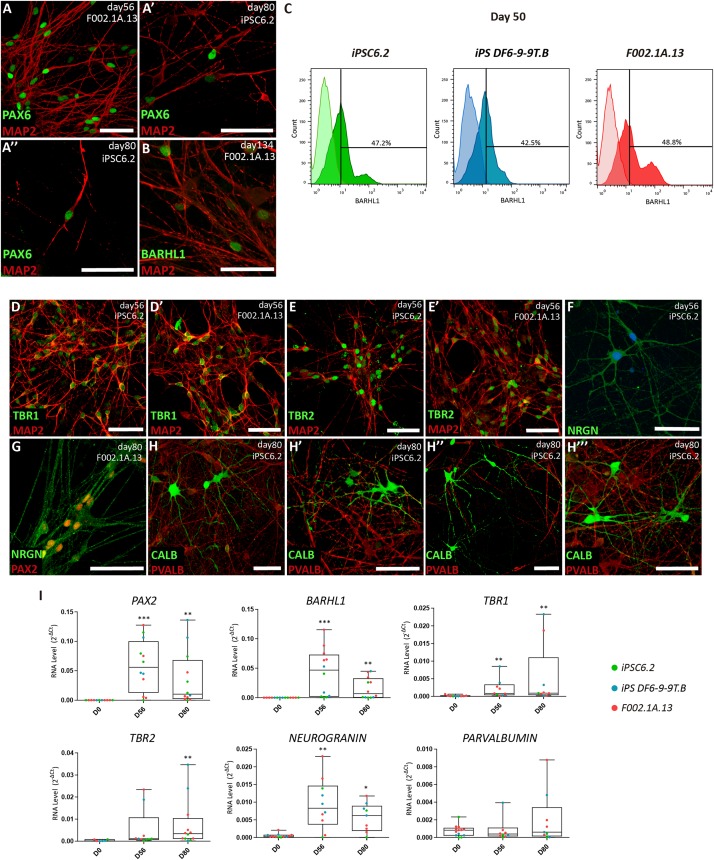
Maturation of distinct types of cerebellar neurons in 2D culture. (A,B) Immunofluorescence analysis on days 56, 80, and 134 of differentiation of the indicated iPSC lines. The depicted MAP2+ neurons have the nuclei stained for PAX6 and BARHL1. Scale bars, 50 μm. (C) Flow cytometry analysis of BARHL1+ cells on day 50 of differentiation of the indicated iPSC lines. (D–H) Immunofluorescence analysis on days 56 and 80 of differentiation of iPSC lines using the indicated antibodies. In panel F, nuclei are stained with DAPI (blue). Scale bars, 50 μm. (A’, A”, E’, H’–H”’) are used for different captures using the same antibodies combinations, regardless of the iPSC line and differentiation day. (I) qRT-PCR analysis of cultures derived from each iPSC line at the indicated time-points. Box-plot diagrams depict mRNA expression levels (2–ΔCt) relative to GAPDH. Each color-coded dot represents data from one differentiation experiment. One-way ANOVA (Dunn’s Multiple Comparison Test), ∗p < 0.05, ∗∗p < 0.01, ∗∗∗p < 0.001; error bars represent SEM.